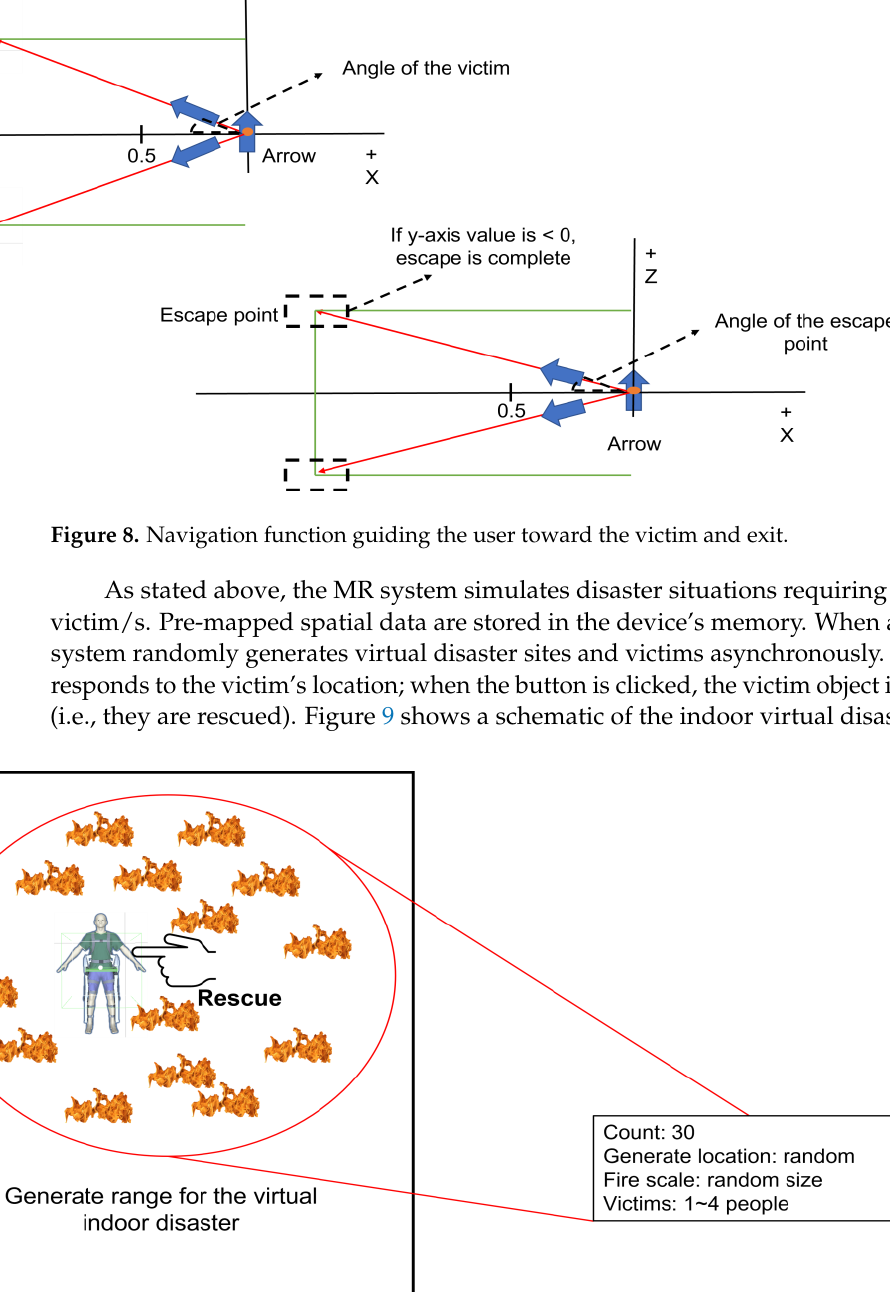
Figure 10. Scenario manager for the MR system.